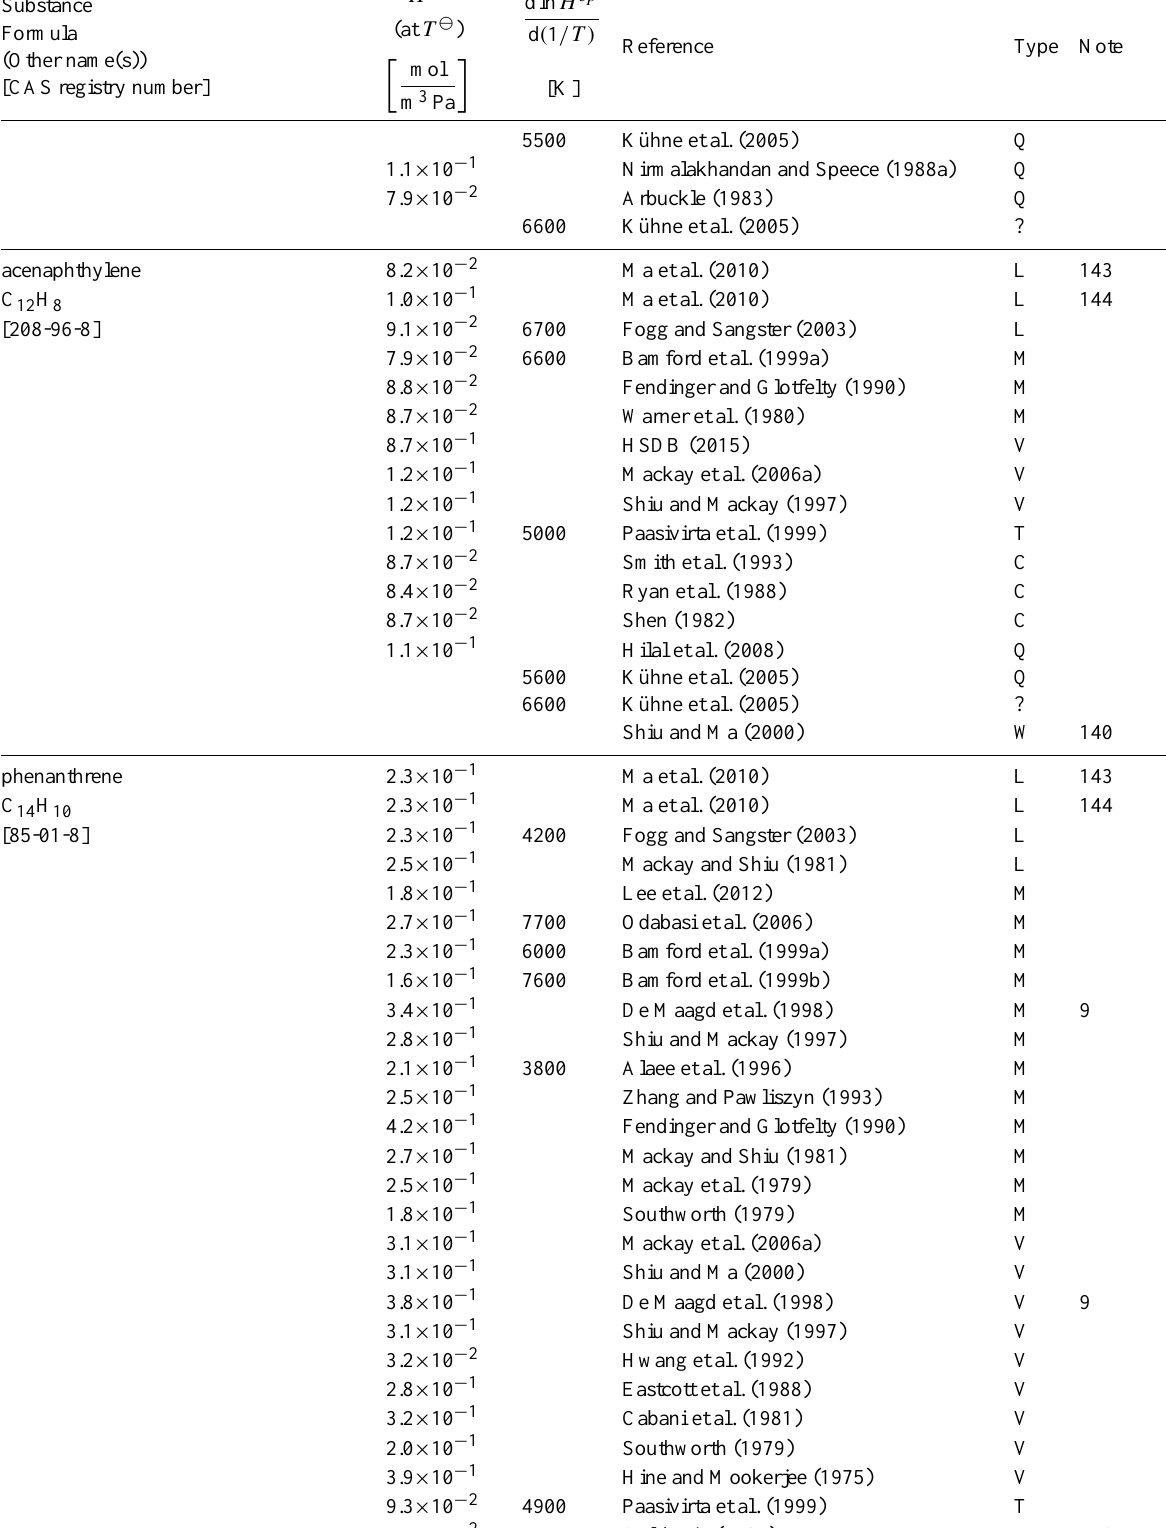
Table 6: Henry’s law constants for water as solvent